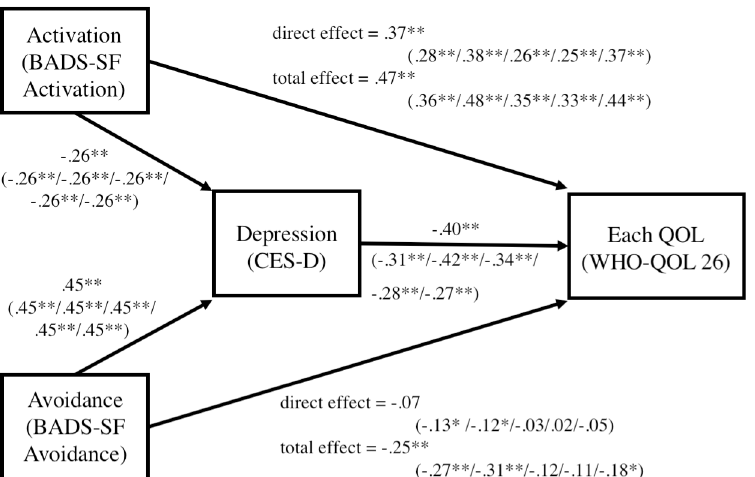
Fig 1. Mediating effect of depression on the relationship between behavioral-activation related factors and QOL. Note. Each value indicatesstandardized path coefficients when each QOL was used as a target variable. WHOQOL-26 Mean Total Score (PhysicalHealth/PsychologicalHealth/Social Relationships/ Environment/Overall QOL). BADS-SF: Behavioral Activation for Depression Scale Short form; CES-D: Center for EpidemiologicStudies Depression Scale; QOL: Quality of Life. ** p < .01, * p < .05.